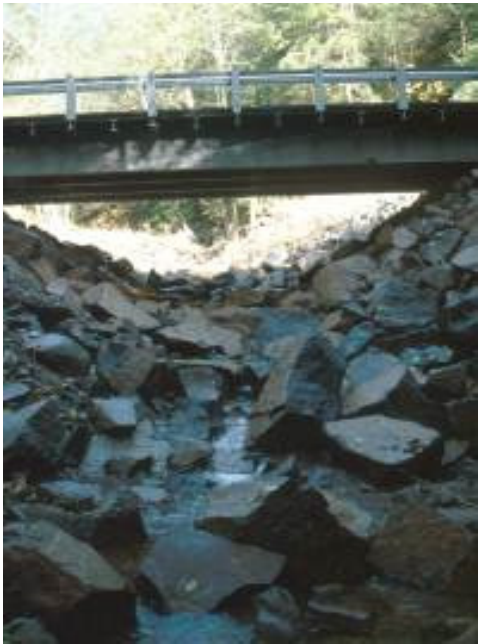
Figure 13. Constructed Cascade (photo courtesy of Dan Perritt).